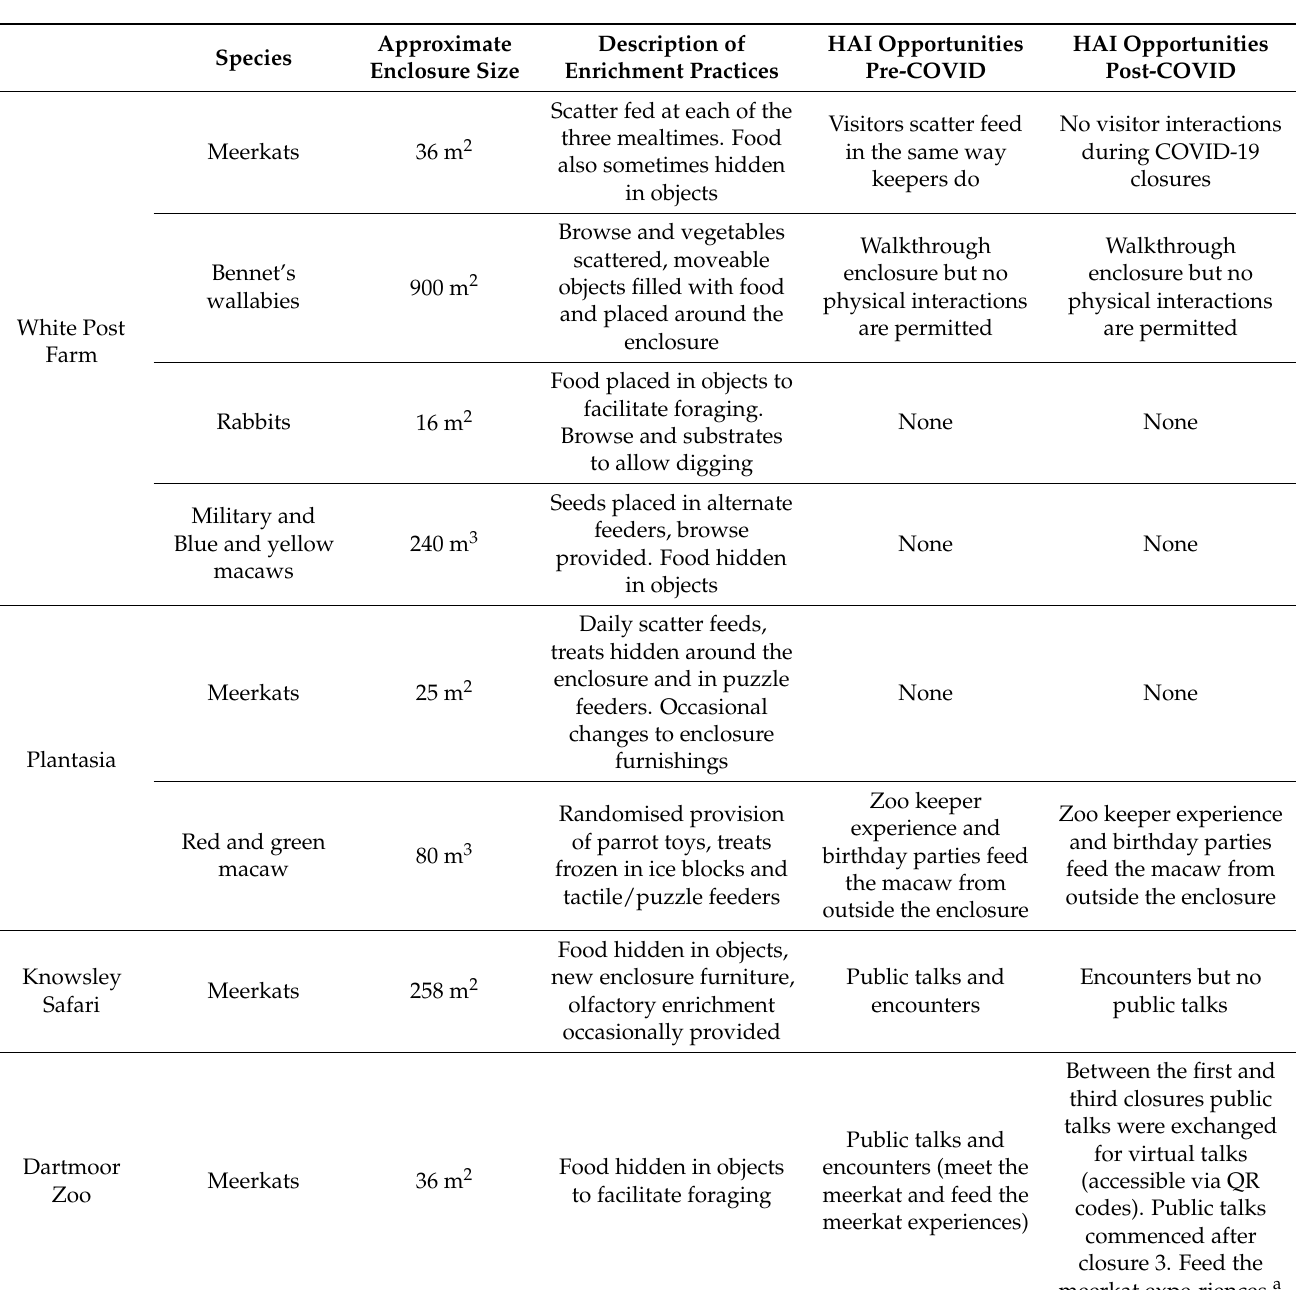
Table 2. An overview of enrichment activities and human–animal interaction opportunities at the study sites prior to and following the COVID-19